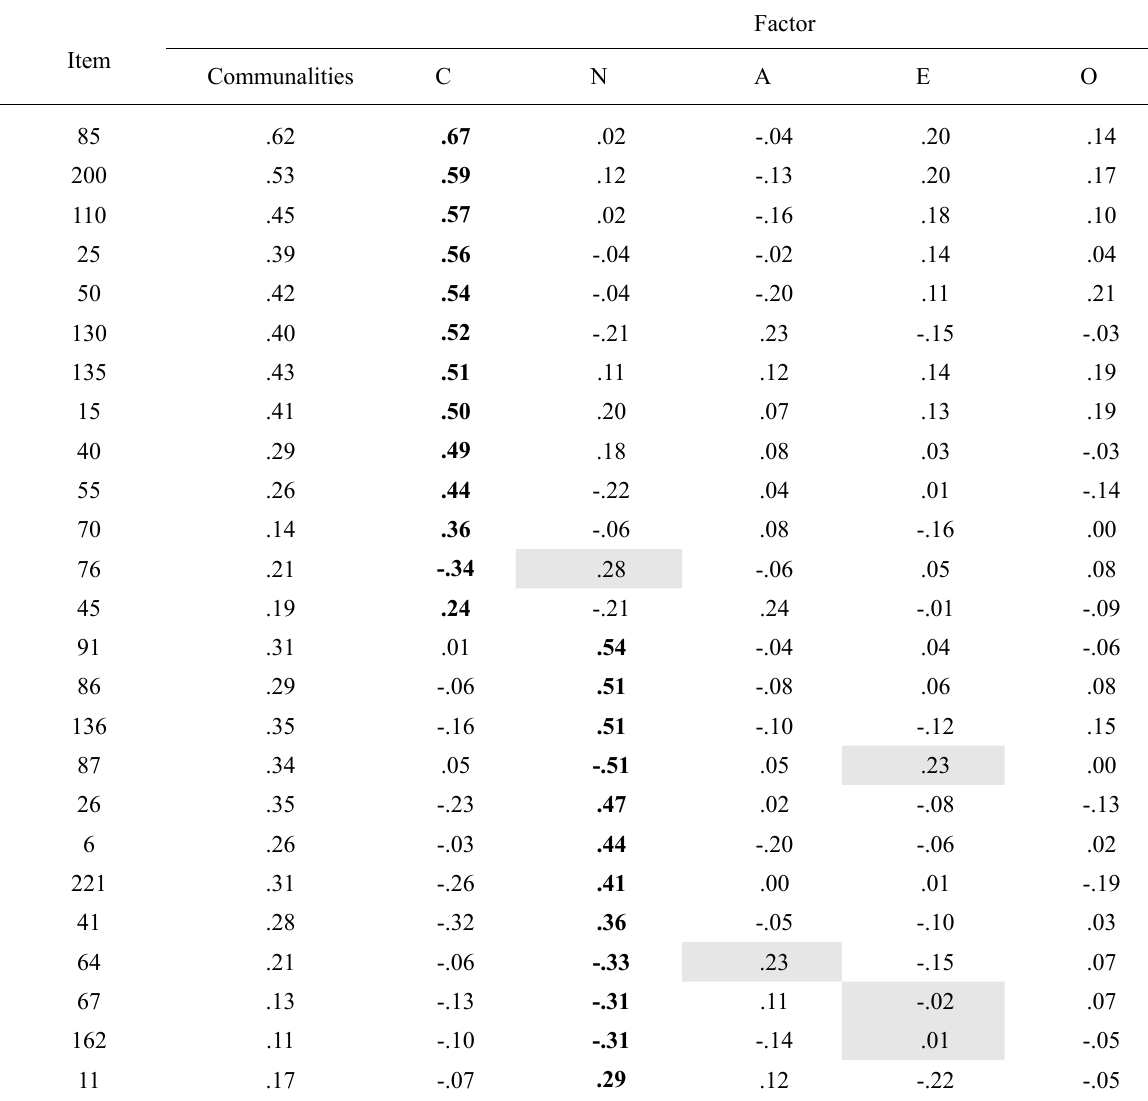
Principal Axis Factors with Direct Oblimin Rotation Solutions of NEO-FFI Items for Primary and Lower Secondary